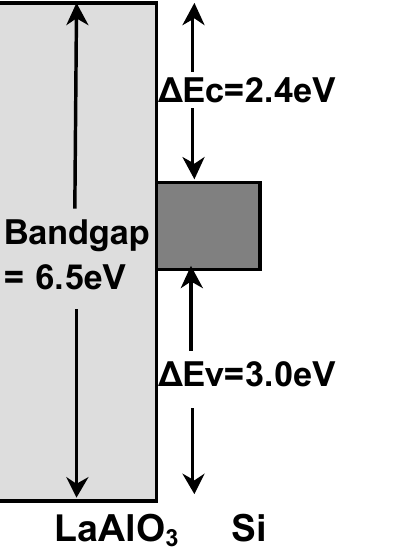
/Si structure determined from 3